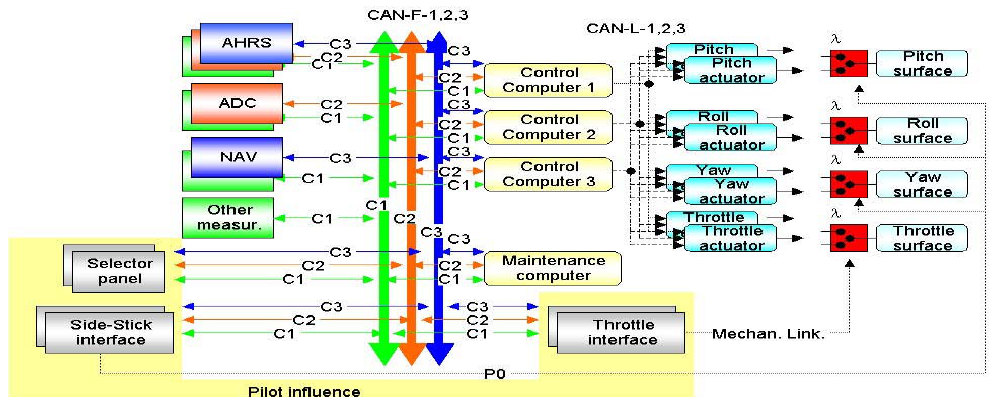
Fig 2. General structure of the fly-by-wire flight control system for